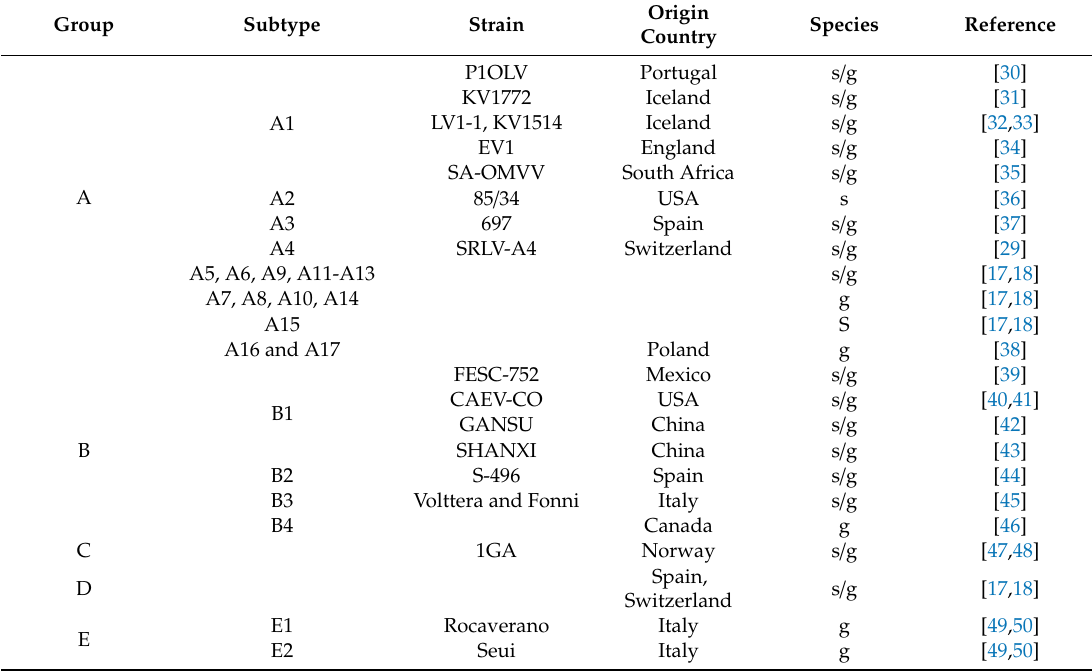
Table 2. Classification of SRLVs